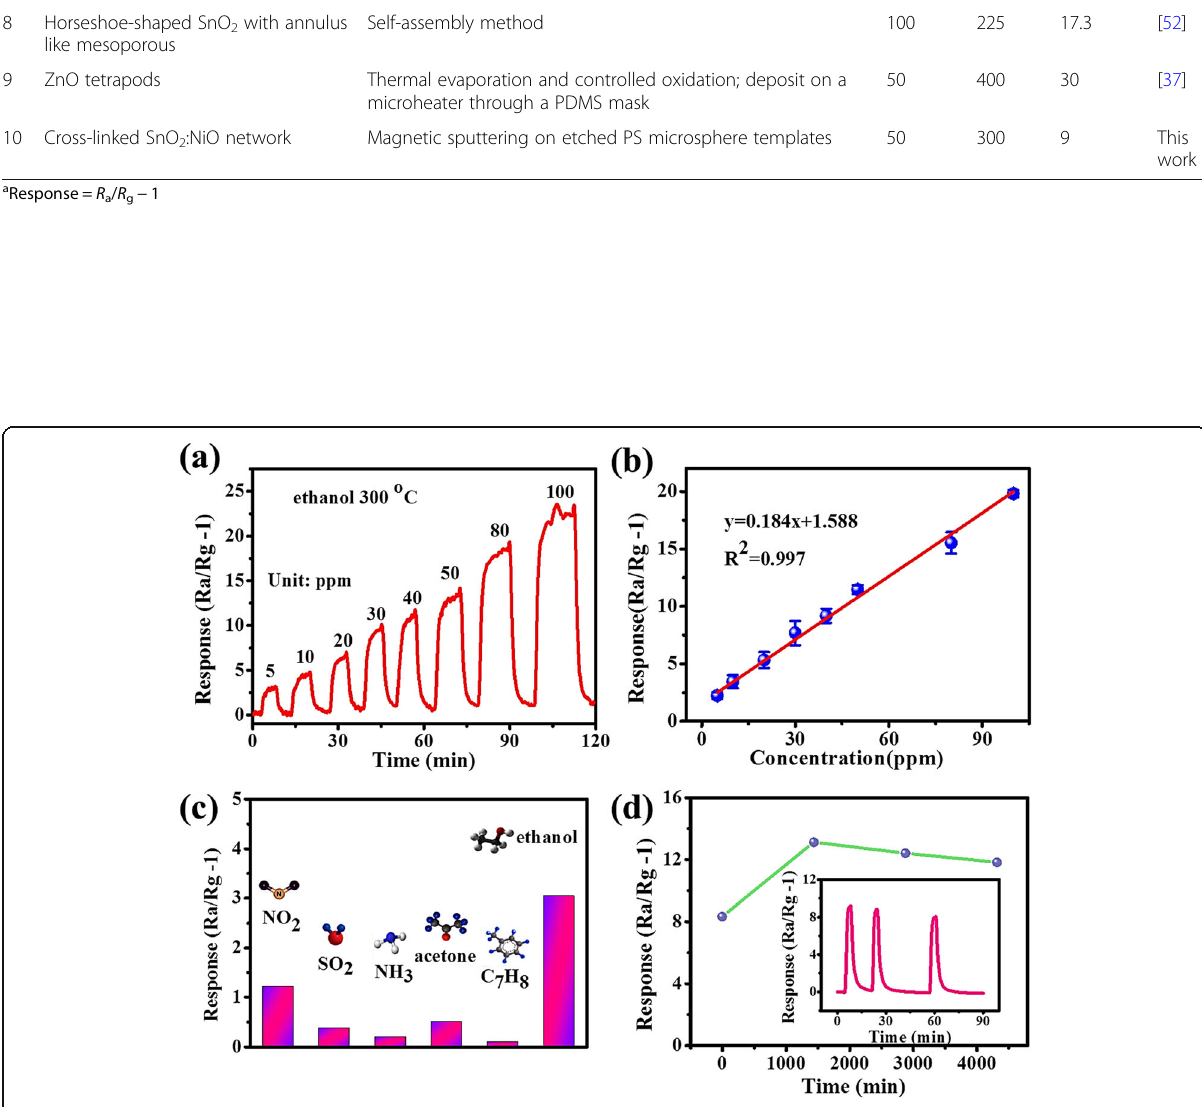
Op.tem. Response a Ref. (ppm) (°C)